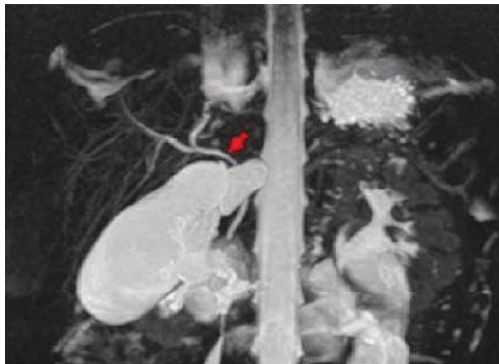
F 2: MR cholangiography: a coronal maximum intensity projection (MIP) shows a distended gallbladder with no sign of the cystic duct